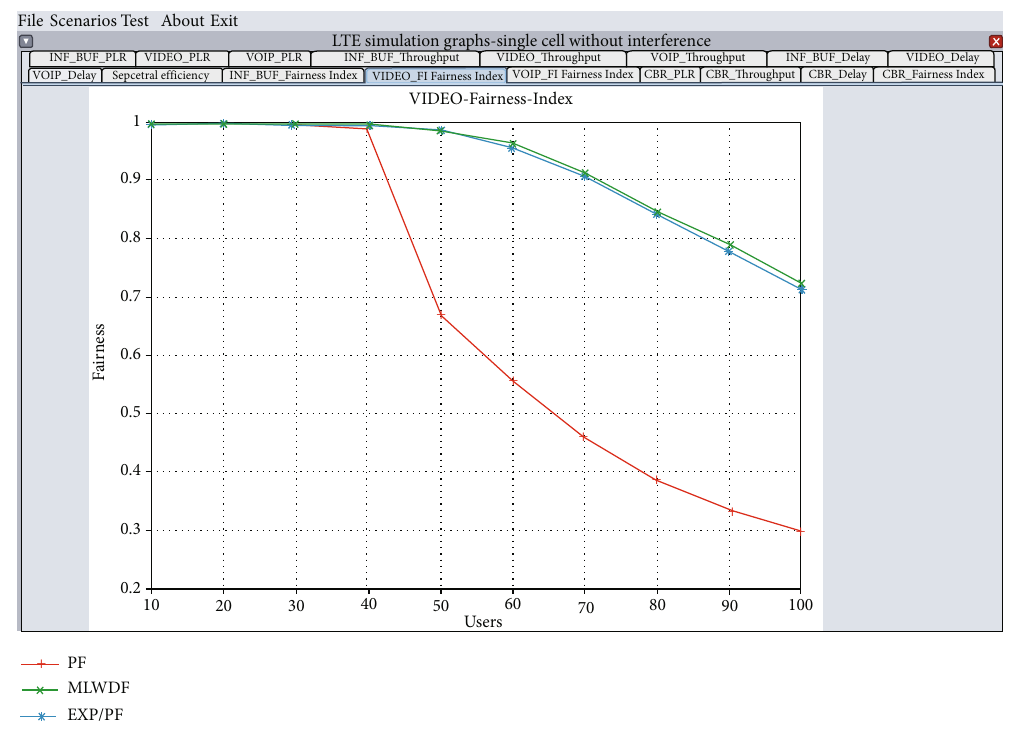
Figure 13: System fairness index vs. number of